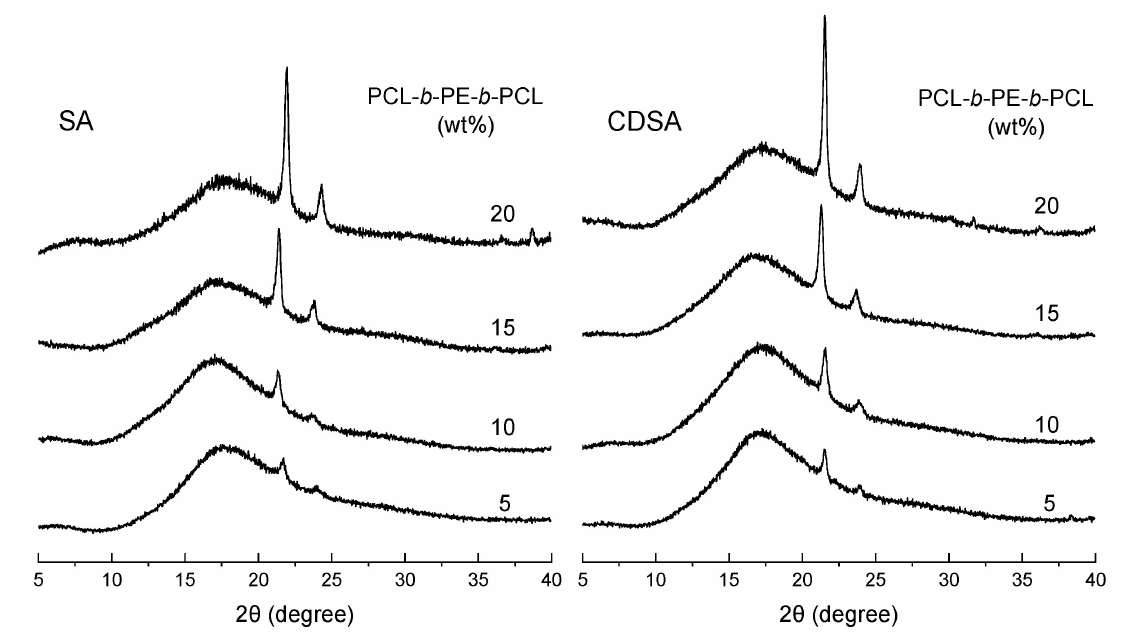
Figure 6. XRD curves of epoxy thermosets containing PCL -b- PE -b- PCL via SA and